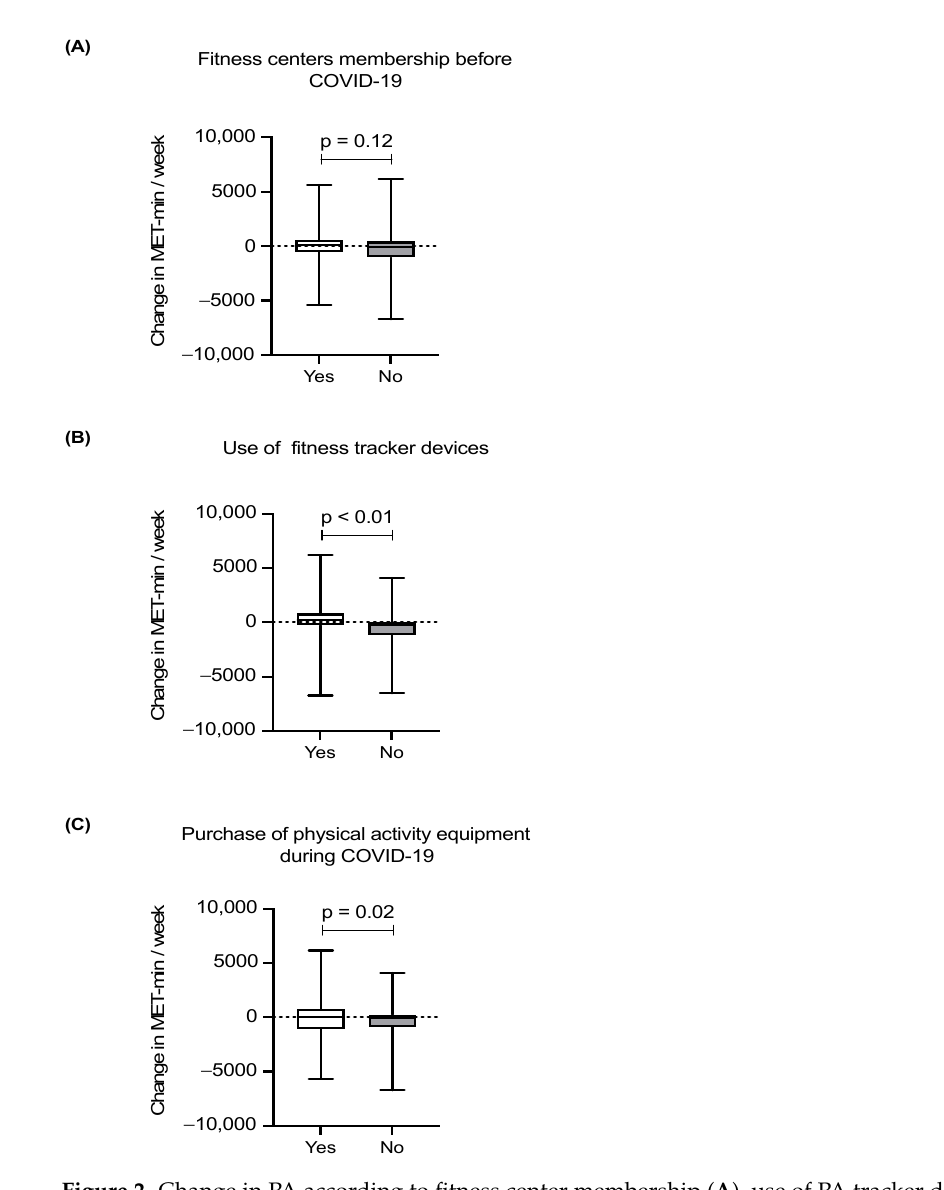
Figure 2. Change in PA according to fitness center membership ( A ), use of PA tracker devices ( B ), and purchase of PA equipment during the pandemic ( C ). Table 3. The results of multinomial logistic regression predicting maintaining of the PA level during the pandemic.